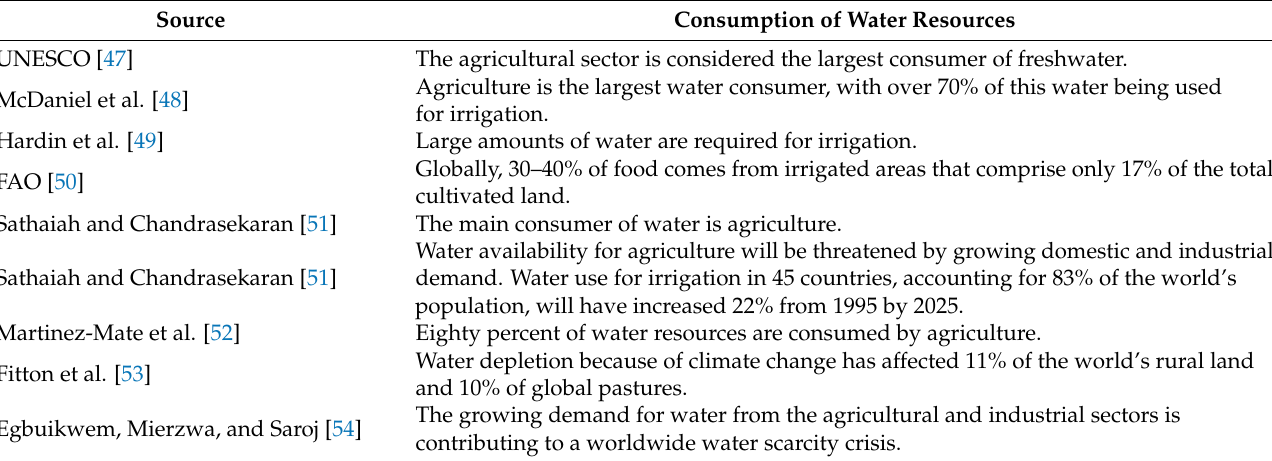
Table 2. Consumption of water resources by conventional